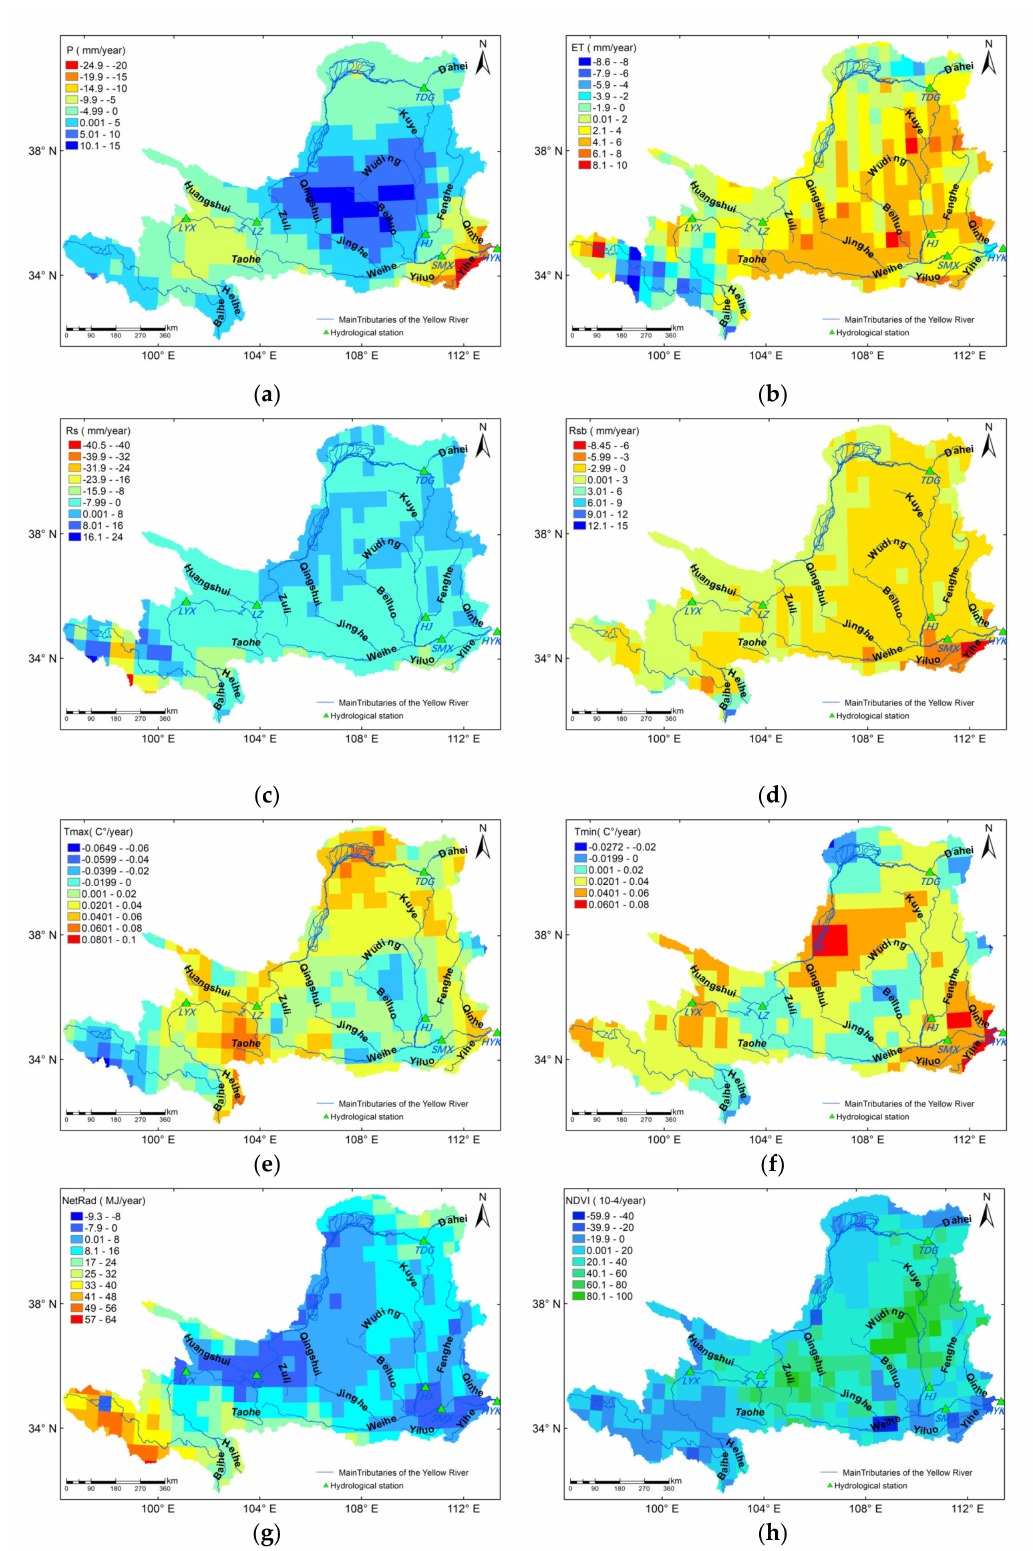
Figure 4. ( a–g ) Distribution maps for the trend slope of hydro-climatic variables and ( h ) NDVI during 2003–2015. LYX is Langyagnxia station; LZ is Lanzhou station; TDG is Toudaogui station; HJ is Hejin station; SMX is Sanmenxia station; and HYK is Huayuankou